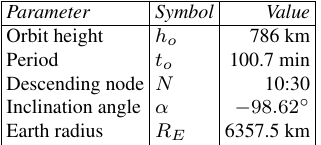
Table 2. Sentinel-2 orbit parameters